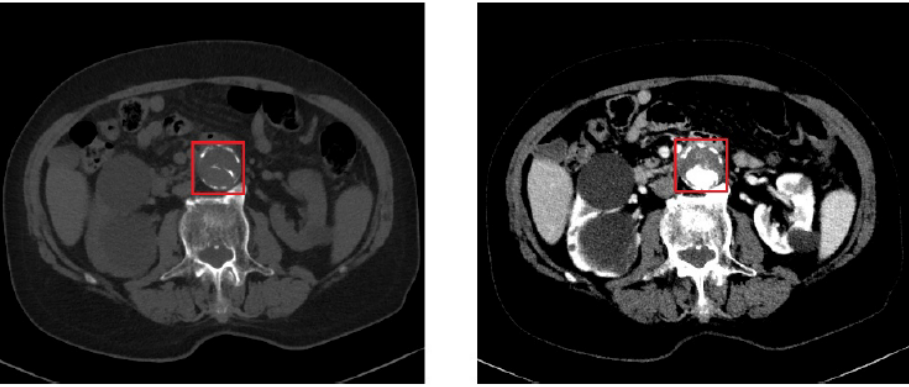
Figure 3. On the left, basal CT image in the presence of an AAA. In the red square (the so called region of interest, ROI) is depicted the aorta artery. On the right, CT image with contrast medium, corresponding to the same CT section shown on the